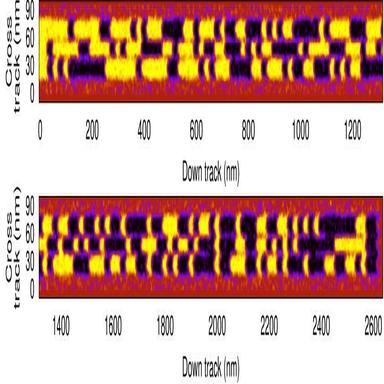
Average magnetisation of forty 135 bit media realisations for use in an adjacent track interference simulation. The magnetisation is represented by yellow for parallel to the z-axis, purple for anti-parallel and red for zero magnetisation. The continuous track has been split in half for viewing.